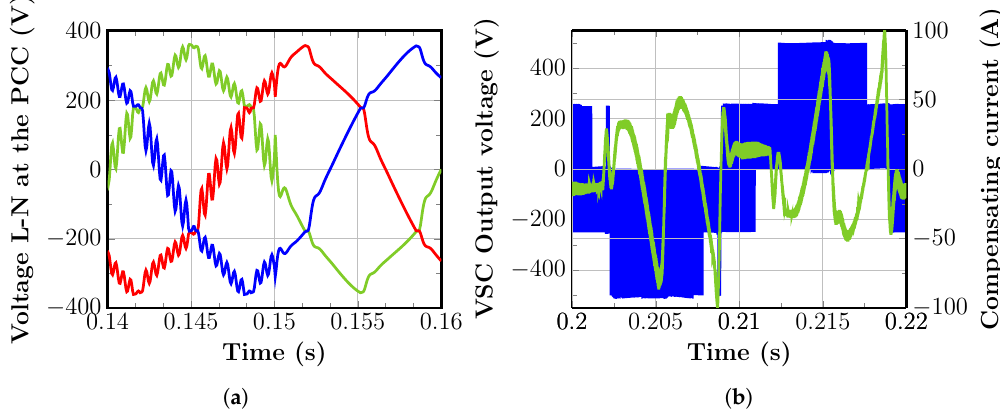
Figure 11. ( a ) V PCC behavior in presence of the 2L-based VSAPF. ( b ) 2L-based VSAPF compensating current I C for the phase A (green) and converter output voltage v o-N for the same phase. VSAPF is activated at t = 0.15 s. The THD V without VSAPF is 10.5% and with the VSAPF is reduced to 6.87%.